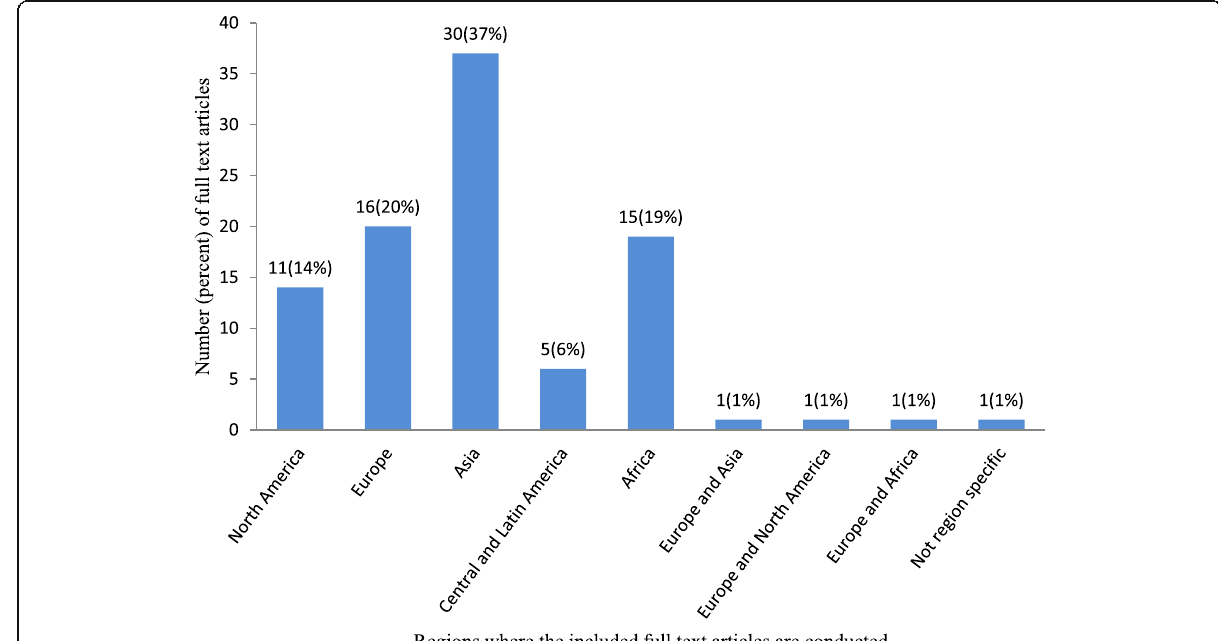
Fig. 2 Regions where the included full-text articles conducted